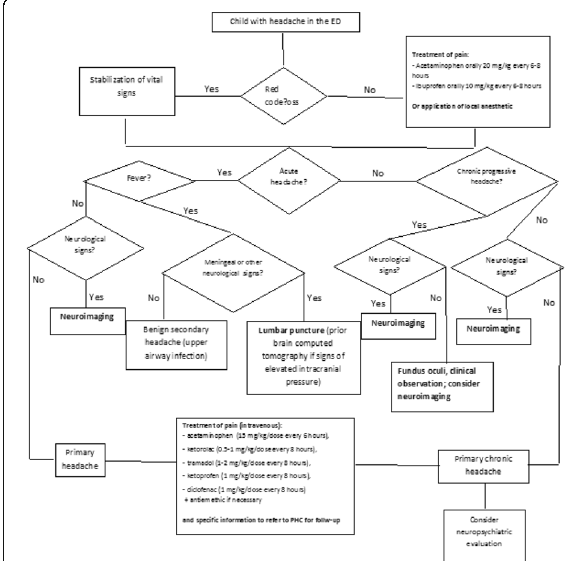
Fig. 1 (abstract P60). diagnostic-therapeutic algorithm for the management of headache in a Pediatric